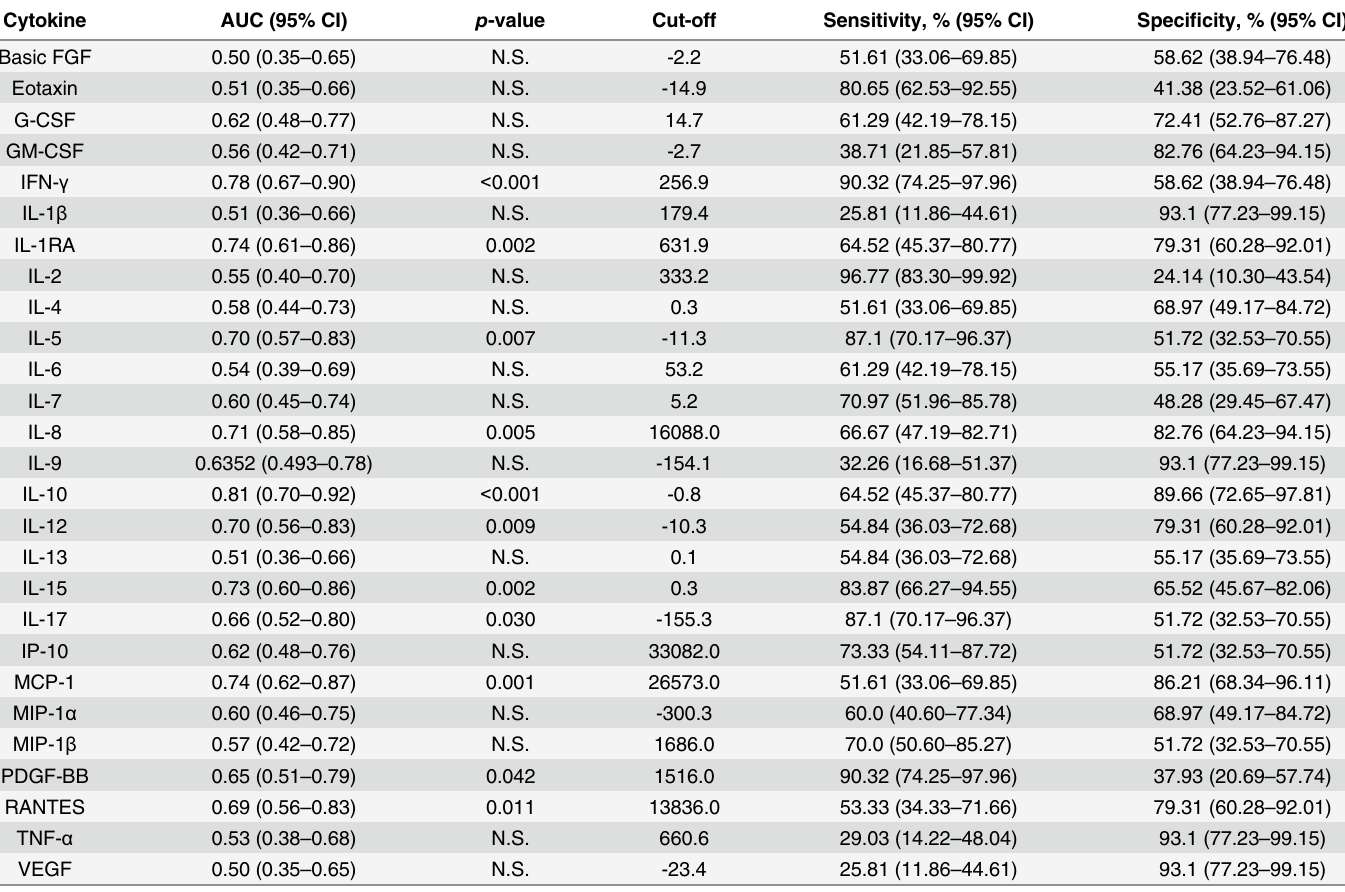
Table 3. AUCs for discriminating active tuberculosis from LTBI (TBAg –